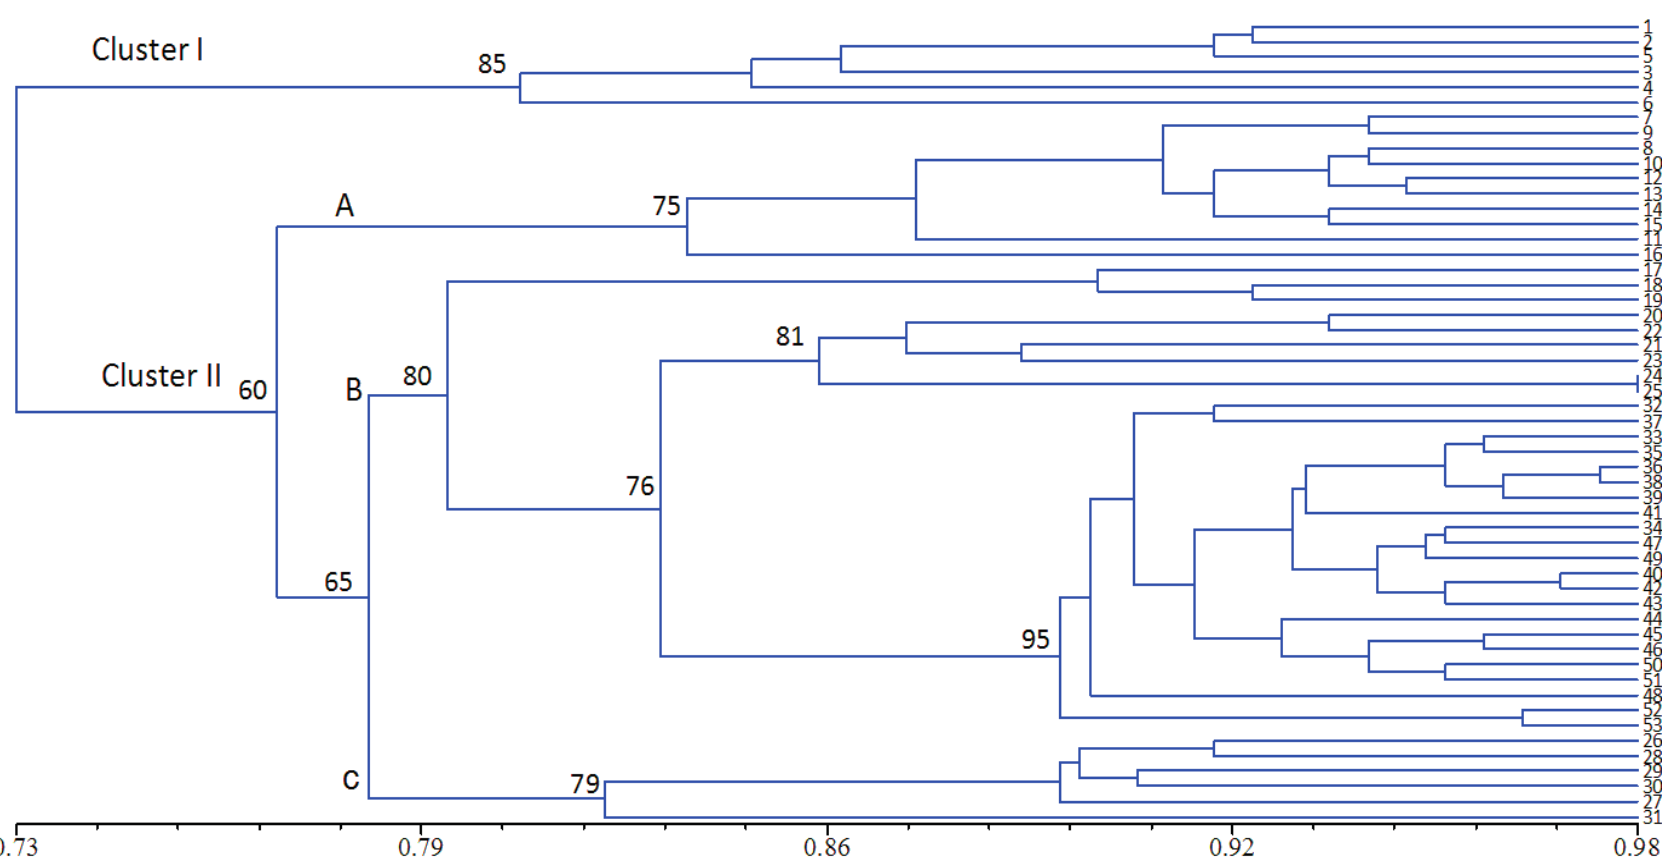
Figure 3. UPGMA-derived dendrogram of 53 E. sibiricus accessions based on Jaccard’s genetic similarity, only bootstrap values higher than 50% are presented. Accessions designations refer to Table